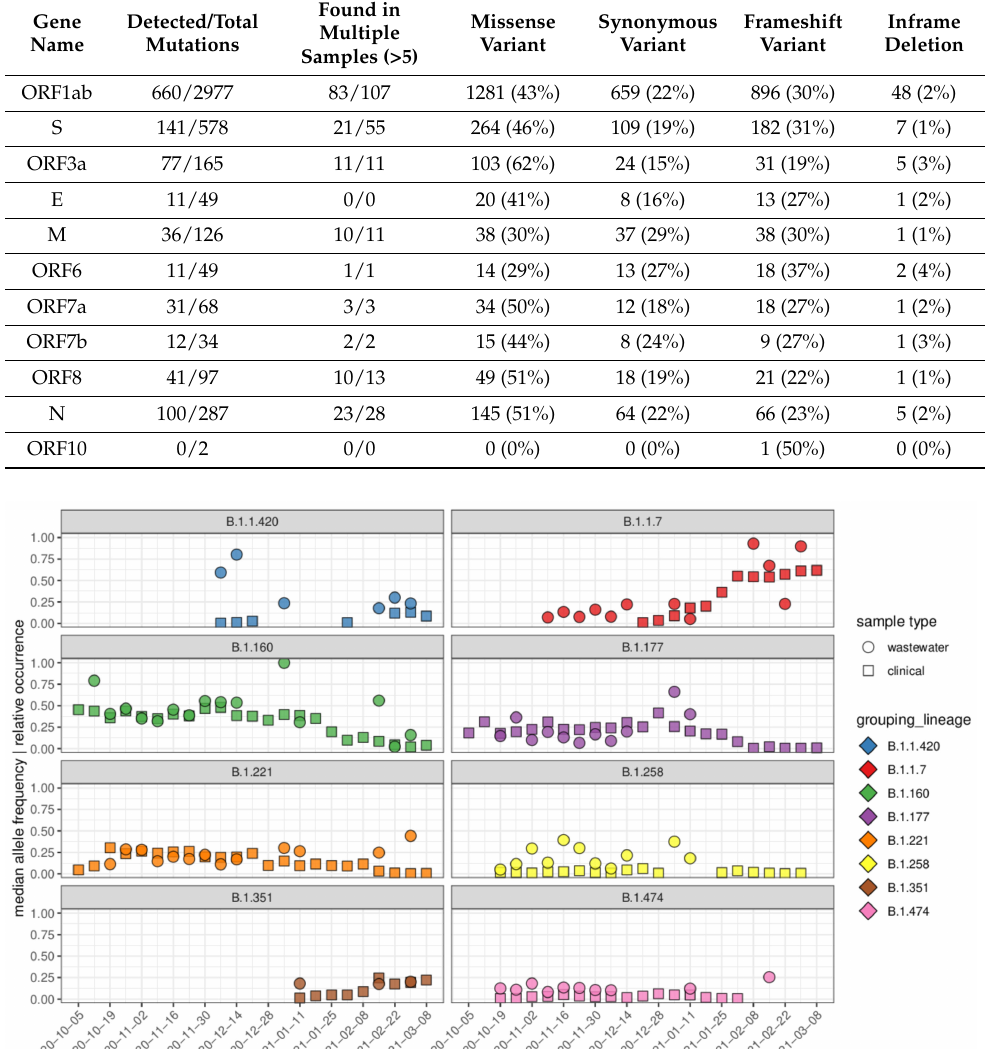
Table 1. Number of nucleotide mutations per gene. The number of mutations in columns 2 and 3 is given as the number of mutations detected in any clinical sample divided by the total number of unique mutations seen in wastewater samples. Annotations of mutations (columns 4–7) are relative to the total number of mutations detected for each gene.